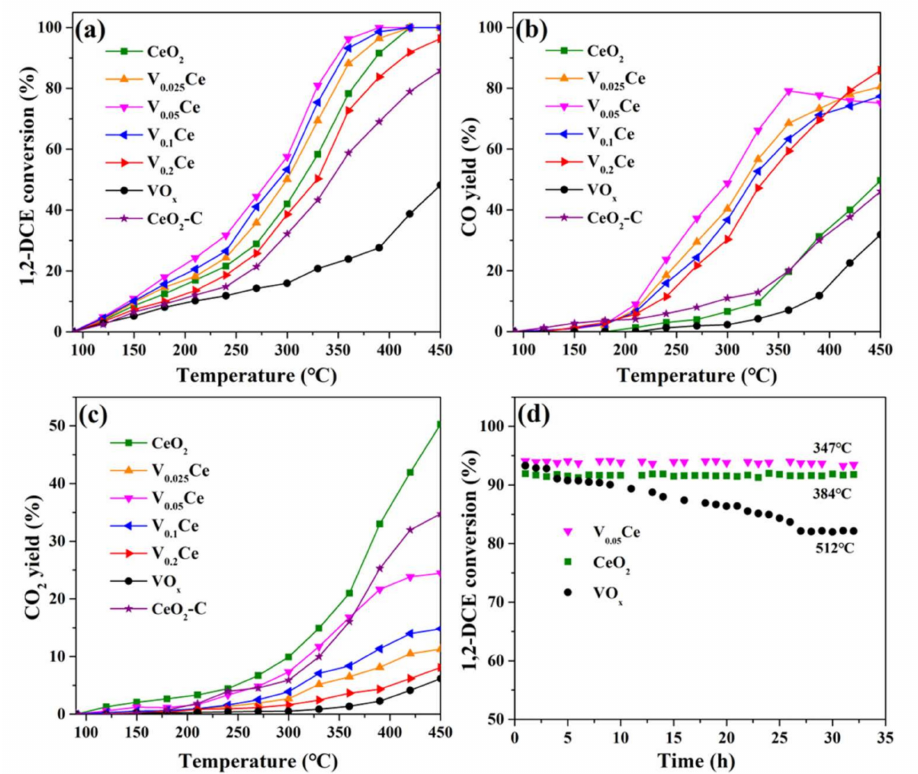
Figure 8. ( a ) Catalytic activity, ( b ) CO yield, ( c ) CO 2 yield, and ( d ) stability of prepared catalysts for 1,2–DCE